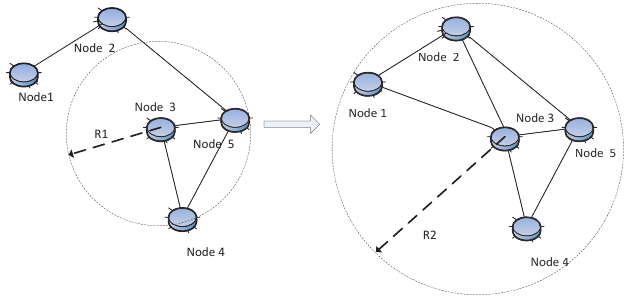
Figure 5. Topology control: adjust the transmission range of Node 3 from R1to R2 in order to improve connectivity.